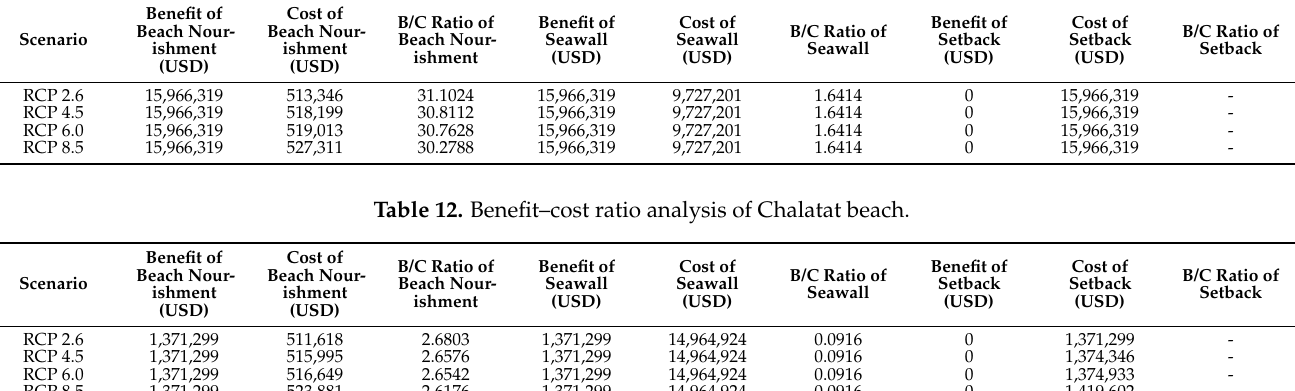
Table 11. Benefit–cost ratio analysis of Pattaya beach.